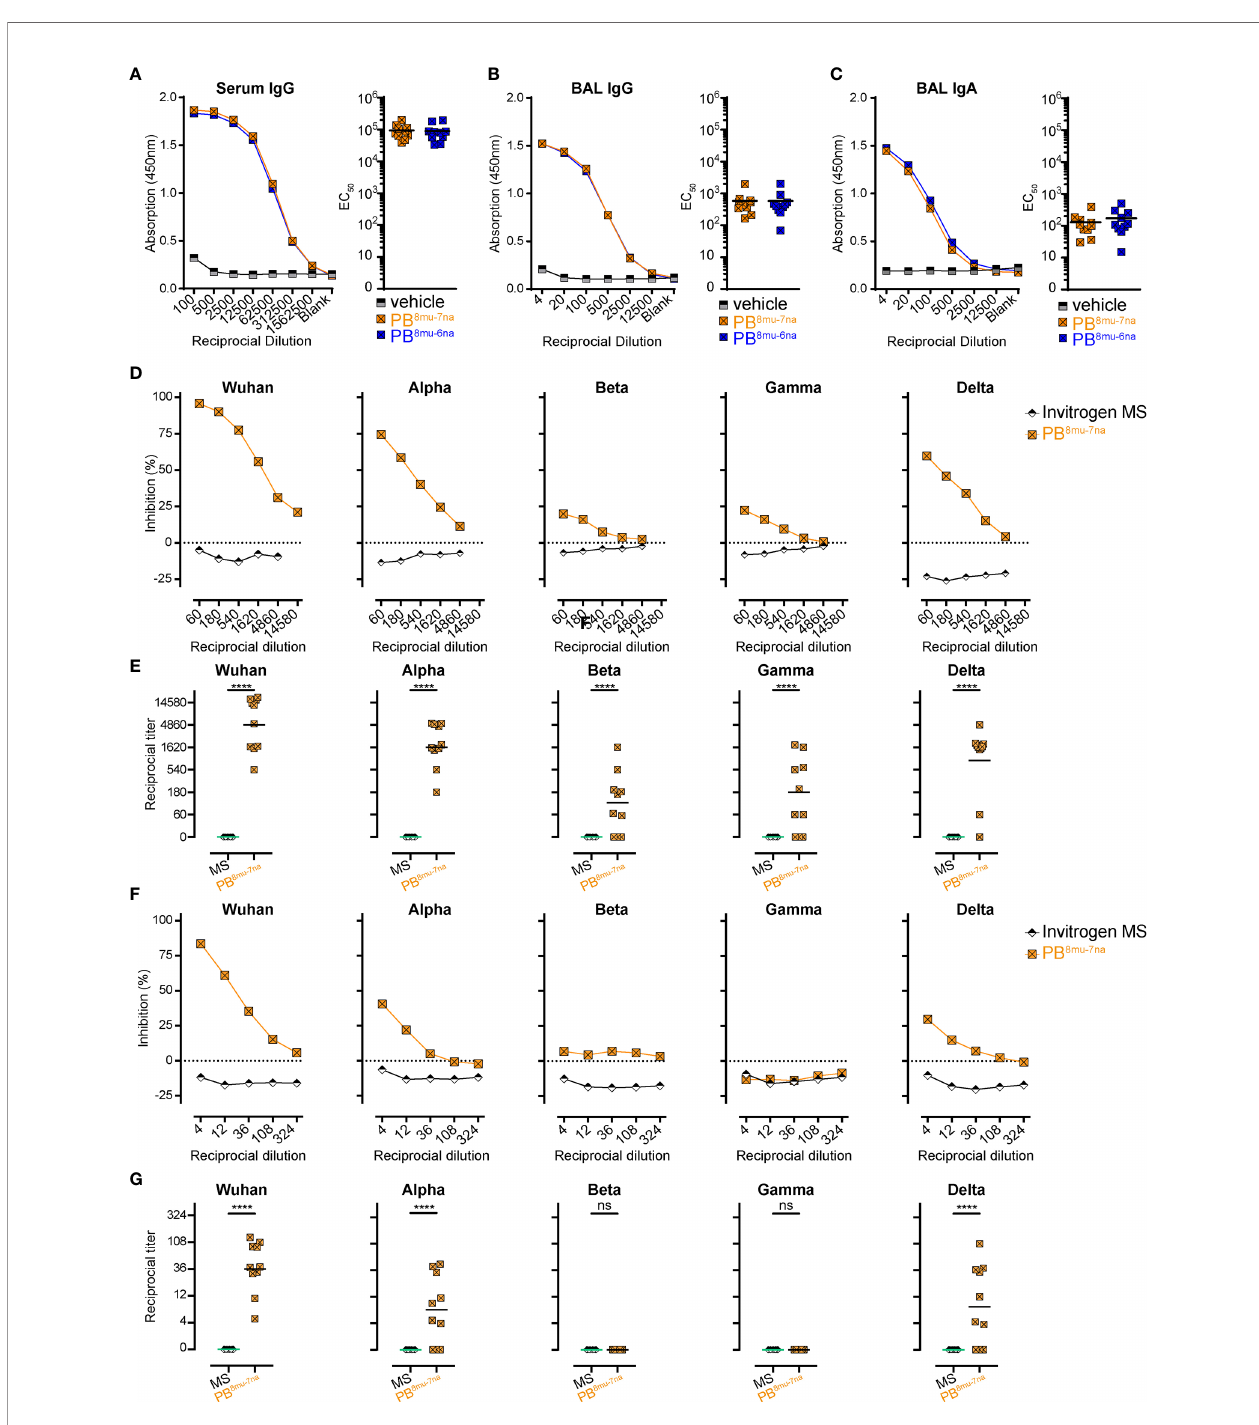
FIGURE 5 | Intranasal boosting with MVA-SARS-2-S induces high titer of neutralizing antibodies in lung and serum. (A – C) Spike-speci fi c antibodies in serum (A) and BAL (B, C) measured by ELISA. Mean group OD values for S-speci fi c IgG (A, B) and IgA (C) determined on serially diluted serum (A) and BAL (B, C) of indicated groups 14 days post boost (d40). (D – G) Neutralizing antibodies in serum (D, E) and BAL (F, G) measured by surrogate virus neutralization test (sVNT). (D, F) Inhibition of binding interaction of SARS-CoV-2 spike-RBD from different SARS-CoV-2 variants of concern (VoC) with ACE2 by addition of sera (D) or BAL (F) of immunized or control mice. Assay performed in triplicate; mean percentages of neutralization. (E, G) Reciprocal titers of neutralizing antibodies against SARS-CoV-2 VoCs from serum (E) or BAL (G) determined as the dilution retaining binding reduction > mean+2SD of non-immunized control mice. (A – G) Pooled data from 2-4 experiments with n = 10 per group. (E, G) Individual values (signs) and mean group value (line). Statistical analysis was done using Chi-square test for trend, ns, not signi fi cant, ****p <